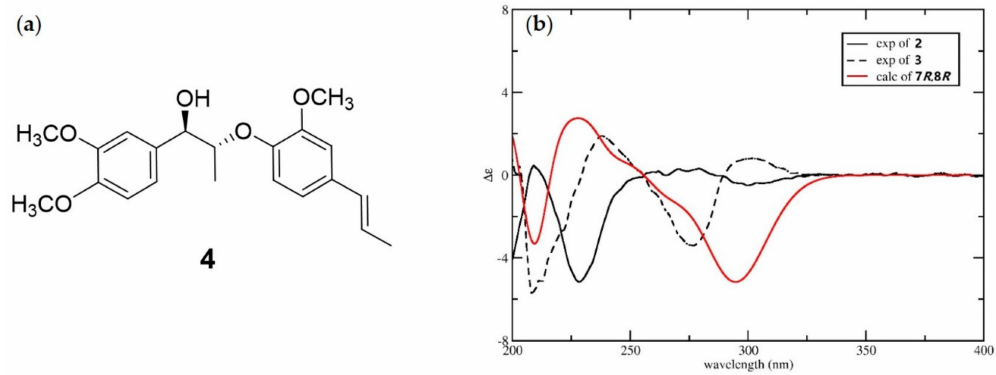
Figure 4. ( a ) Chemical structure of model compound 4 ; ( b ) Experimental ECD spectra of 2 and 3 , and calculated ECD spectra for 4